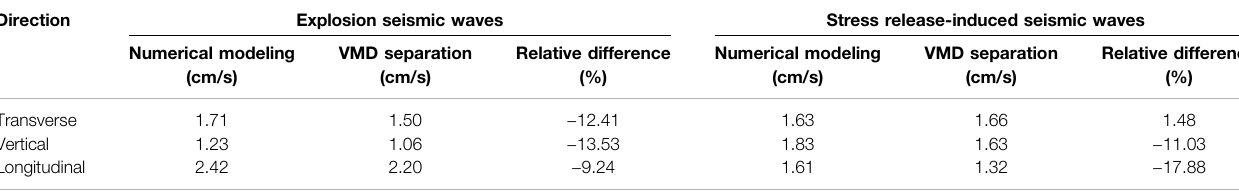
TABLE 1 | PPV of the respective seismic waves obtained by the numerical modeling and the VMD separation.